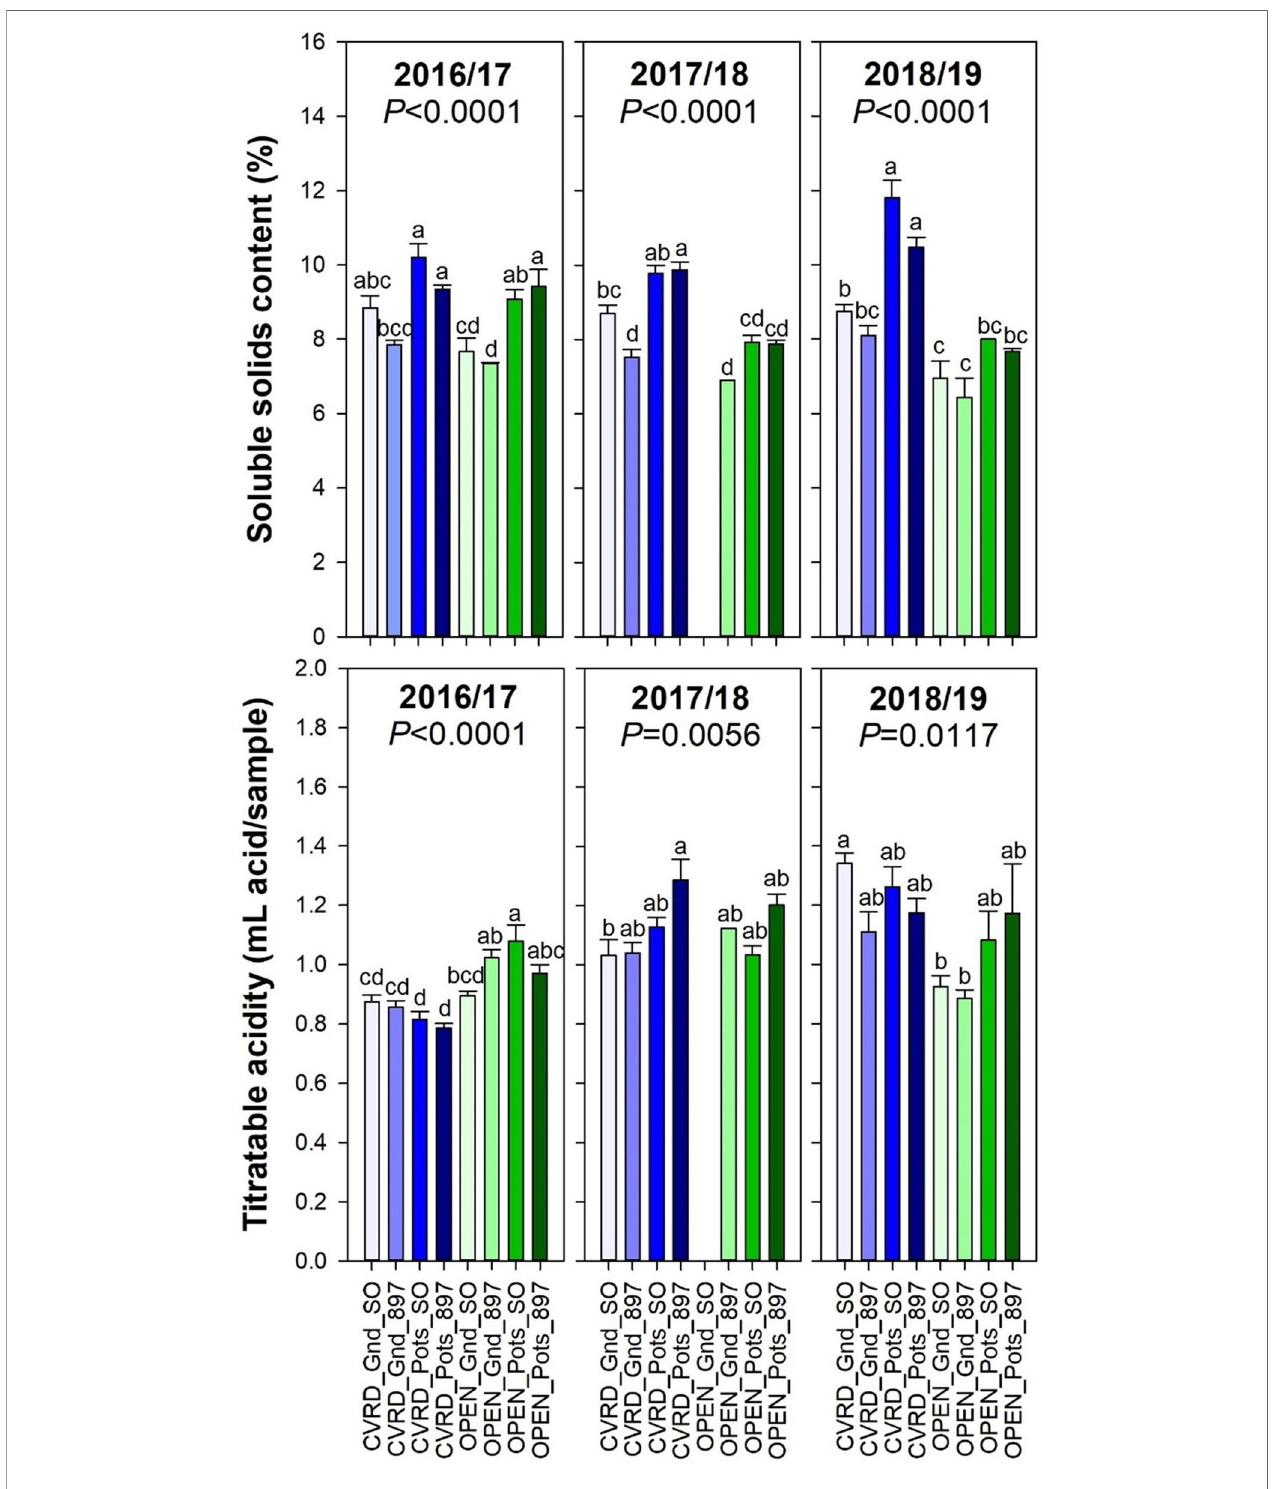
FIGURE 7 | Soluble solids content (top) and titratable acidity (bottom) of “ Ray Ruby ” grapefruit trees cultivated under two production systems (screenhouse, CVRD and open-air, OPEN), two planting systems (in-ground, GND and potted, POTS), and two rootstocks ( “ Sour Orange, ” SO, and “ US-897 ” ), with four replications arranged in a split-split-plot experimental design. Mean ± standard error of four replications. Means with the same letter are not signi fi cantly different from each other at 5% probability ( P ≤ 0.05) using Tukey mean comparison test.